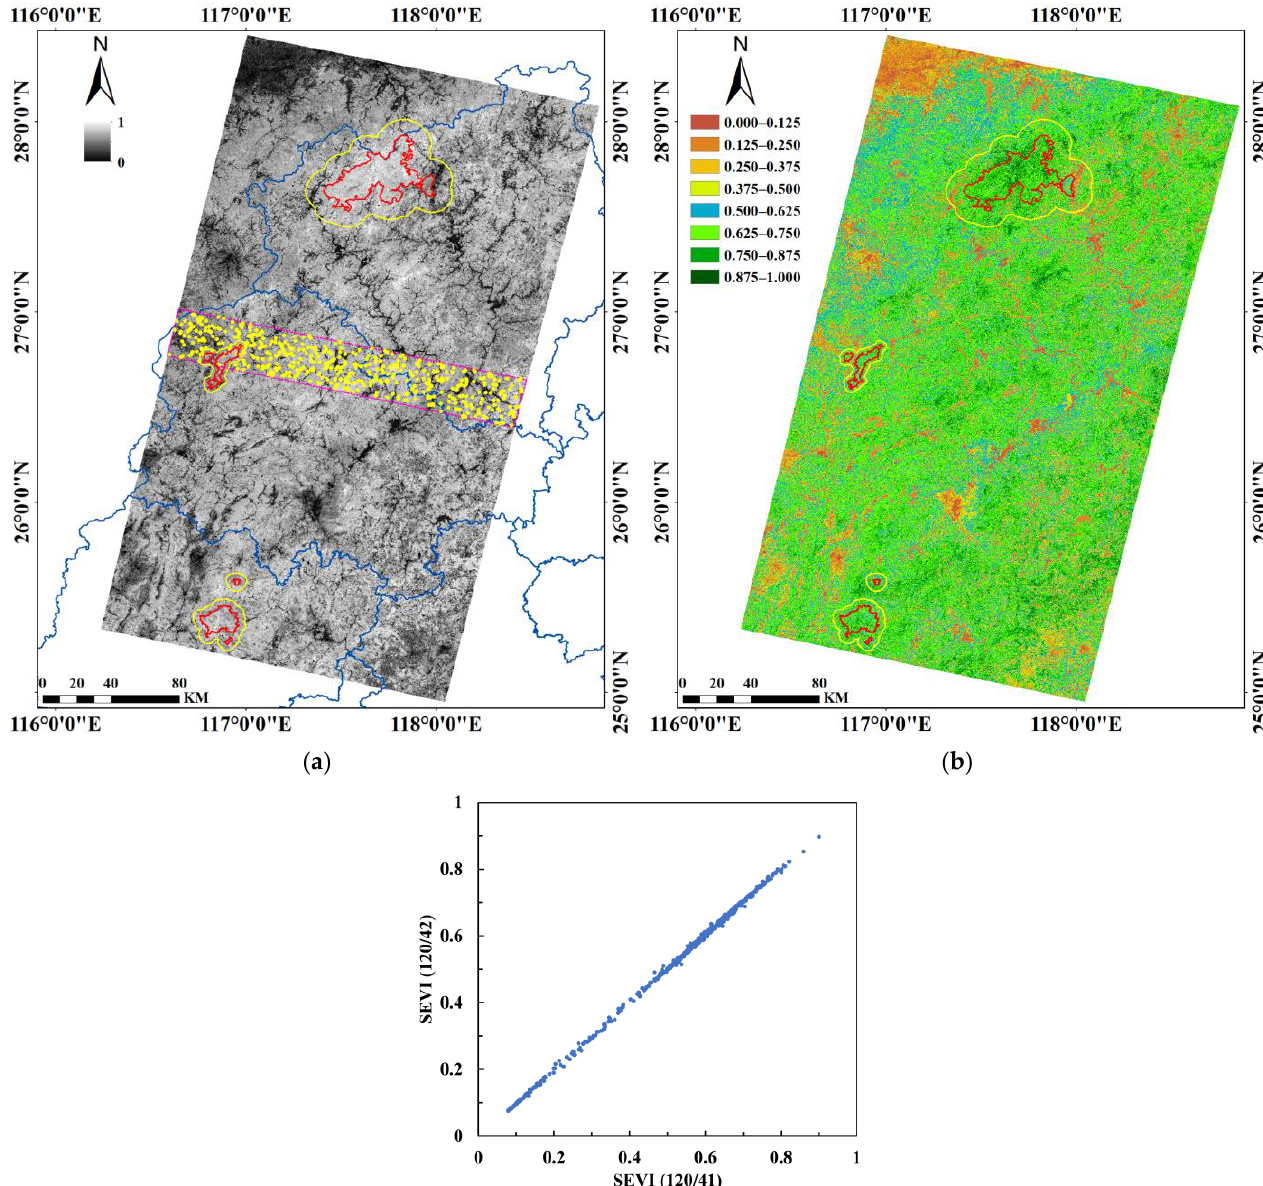
Figure 4. Mosaicked SEVI and scatter plots: ( a ) SEVI and points in intersected area (yellow points); ( b ) graded SEVI; ( c ) scatter plots of SEVI points in intersected area.